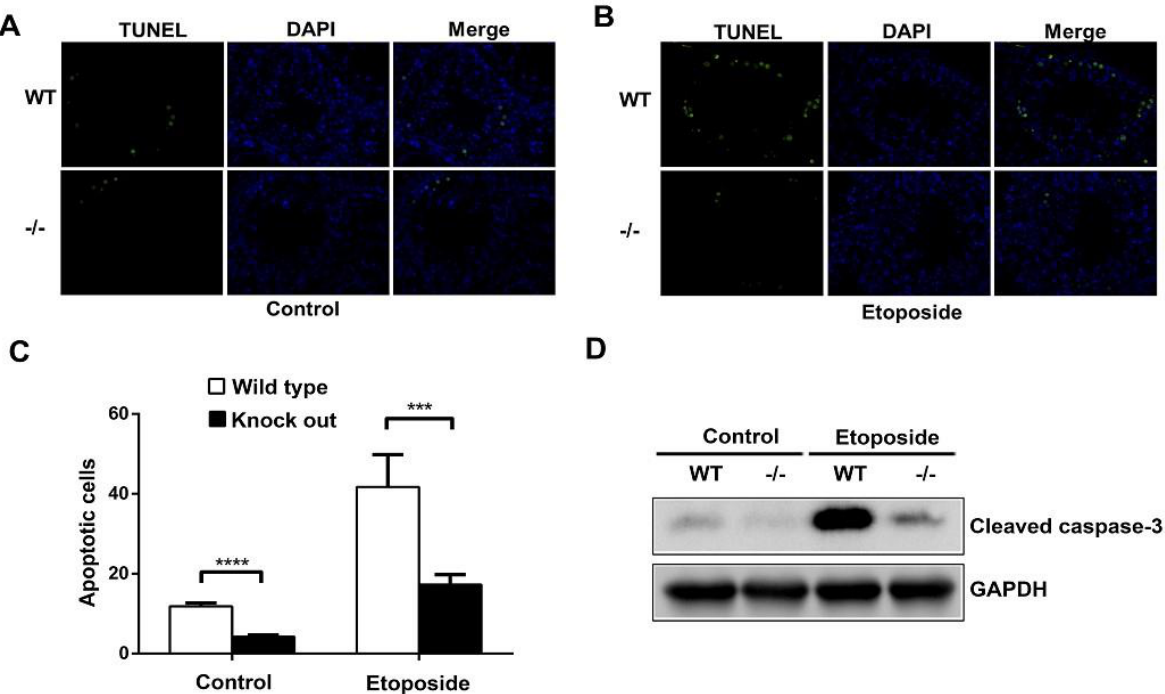
Figure 4. ASB17 deficiency prevents the apoptosis of spermatogonia induced by etoposide in male mice. ( A , B ) TUNEL assay was used to check the apoptotic cells in the testes of ASB17 +/+ and ASB17 − / − mice in control ( n = 4) ( A ) and etoposide-induced group ( n = 5) ( B ). TUNEL (green) and DAPI (blue) were observed. Bar = 50 µ m. ( C ) Quantification and comparison of apoptotic cells of the ASB17 +/+ and ASB17 − / − testes in the control and etoposide-induced groups. ( D ) Western blot analysis of cleaved-Caspase-3 protein expression in the testes from WT and ASB17 −/− mice of the control and experiment groups. GAPDH was used as a loading control. For each mouse, 100 random seminiferous tubules sections were analyzed to count the apoptotic cells, and per 10 random tubules, random tubules cross-sections were presented as a number. Data shown are the mean ± SEM. ***, p < 0.01; ****, p < 0.0001.